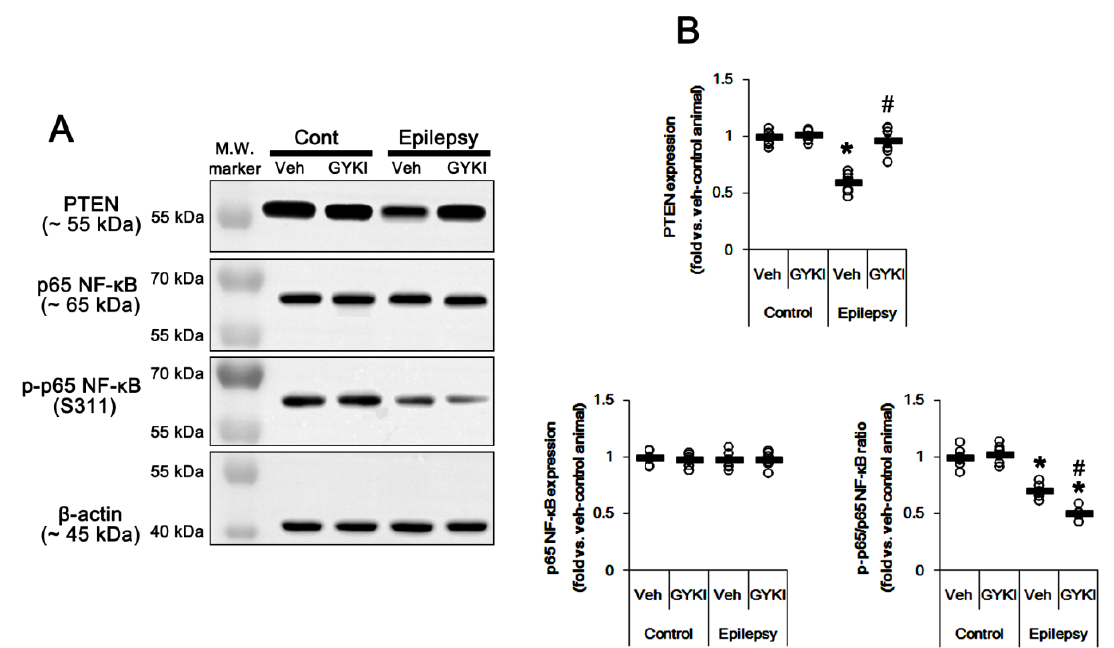
Figure 6. The e ff ect of GYKI 52,466 (GYKI) on PTEN and p65 NF- κ B expression / phosphorylation in control (cont) and epileptic rats. ( A ) Representative images for Western blot of PTEN, p65 NF- κ B, and p-p65 NF- κ B level in the hippocampal tissues. ( B ) Quantifications of PTEN, p65 NF- κ B, and p-p65 NF- κ B level in the hippocampal tissues. Open circles indicate each individual value. Horizontal bars indicate mean value. Error bars indicate SEM (*, # p < 0.05 vs. vehicle (Veh)-treated control animal and vehicle-treated animals, respectively; one-way ANOVA with post hoc Bonferroni’s multiple comparison; n = 7, respectively).